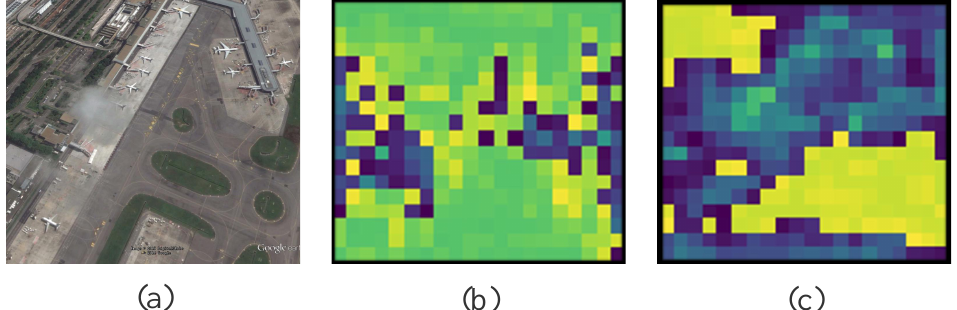
Figure 5. The feature map comparison of YOLOv5 and YOLOv5 with Coordinate Attention module. Where, ( a ) is the original remote sensing image; ( b ) is the feature map without the Coordinate Attention module; ( c ) is the feature map with the Coordinate Attention